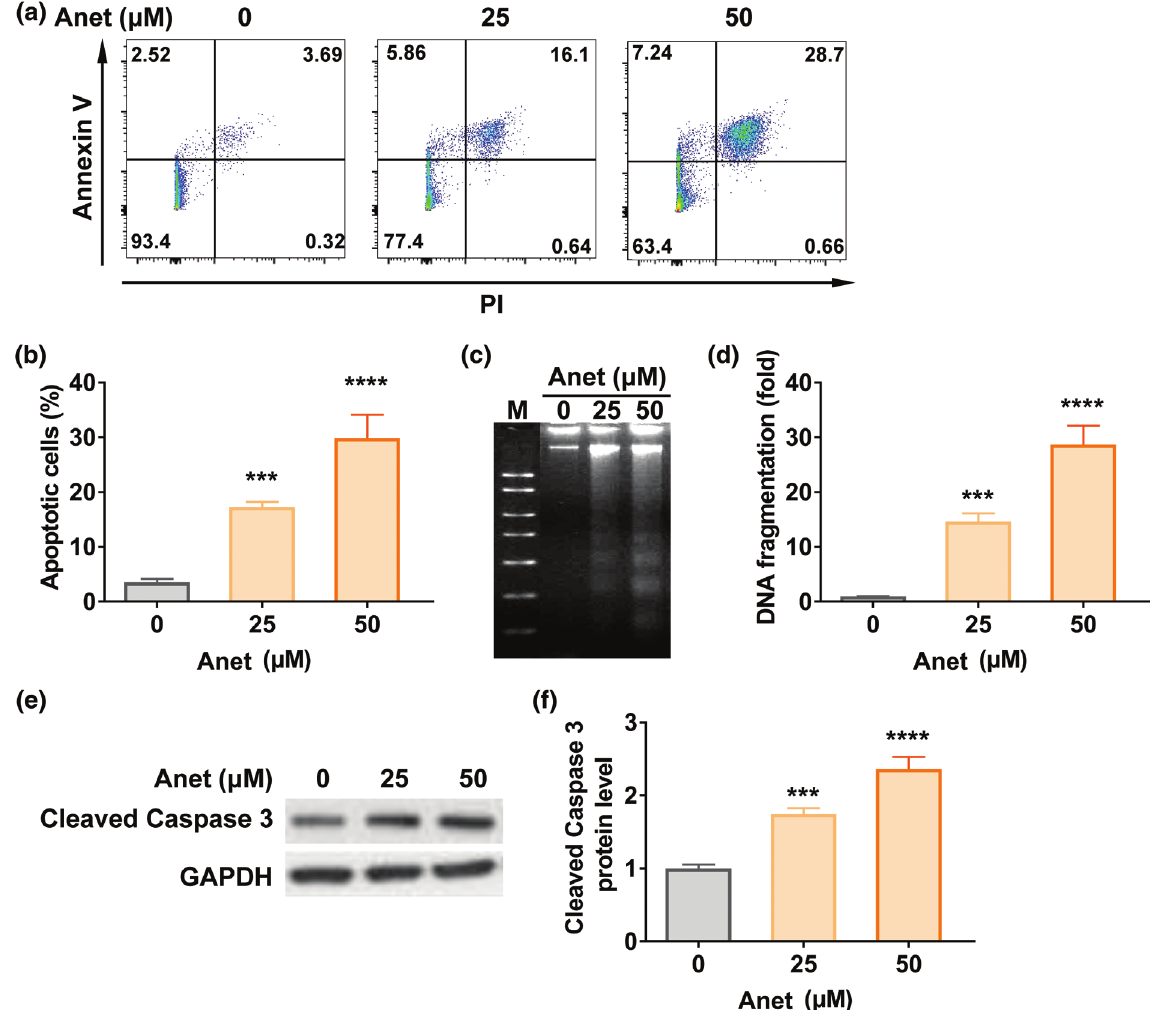
Fig. 2. Anethole promoted the apoptosis of A549 cells. A549 cells were treated with anethole at the indicated concentrations for 48 h, and cell apoptosis was determined by FACS (a and b), DNA fragmentation (c and d), and the immunoblotting assays (e and f). Four replicated wells were designed for each condition. Error bar represents SEM. *** P < 0.001 and **** P <